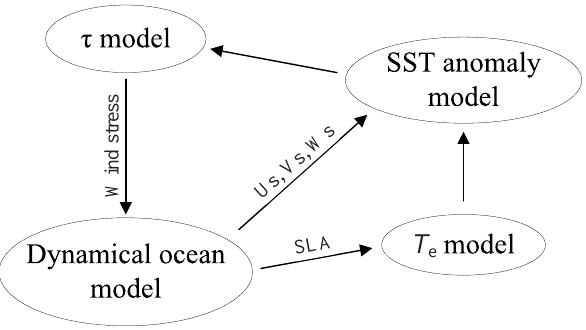
Figure 1. A schematic illustrating the ICM consisting of a dynami- cal ocean model, an SST anomaly model with an empirical parame- terization for T e in terms of SLA, and a statistical atmospheric wind stress ( τ) model. Adopted from Zhang et al.